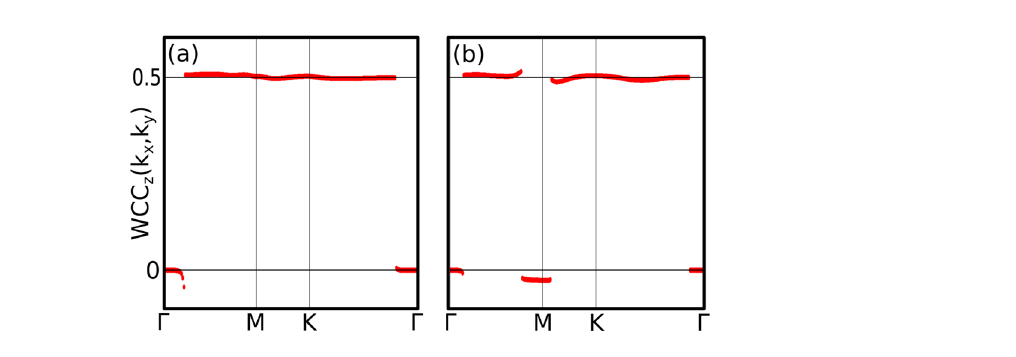
Figure 6. Wannier charge centers ( a ) For P = 0 GPa (T1), around the Ŵ point and due to the snake-like nodal line a jump of 0.5 happens. ( b ) For P = 6 GPa (T2), due to the new topological nodal line a second jump of − 0.5 appears around the M